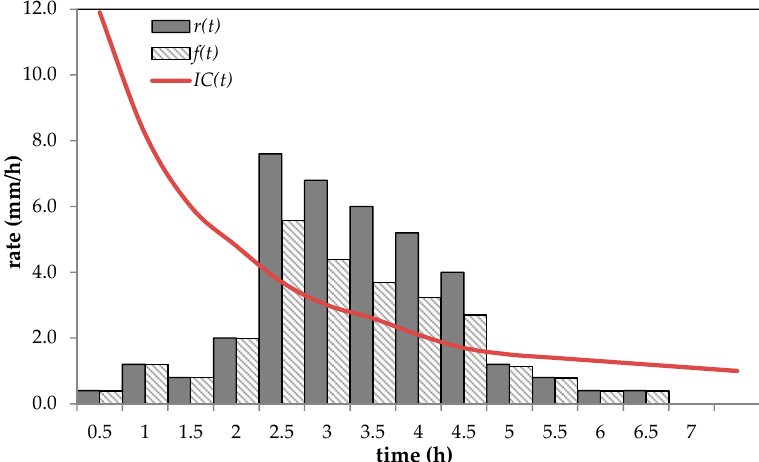
Figure 1. Infiltration capacity, IC ( t ), and infiltration rate, f ( t ), of a silty loam soil under a natural rainfall event (observed in Central Italy) characterized by a variable intensity, r ( t ).